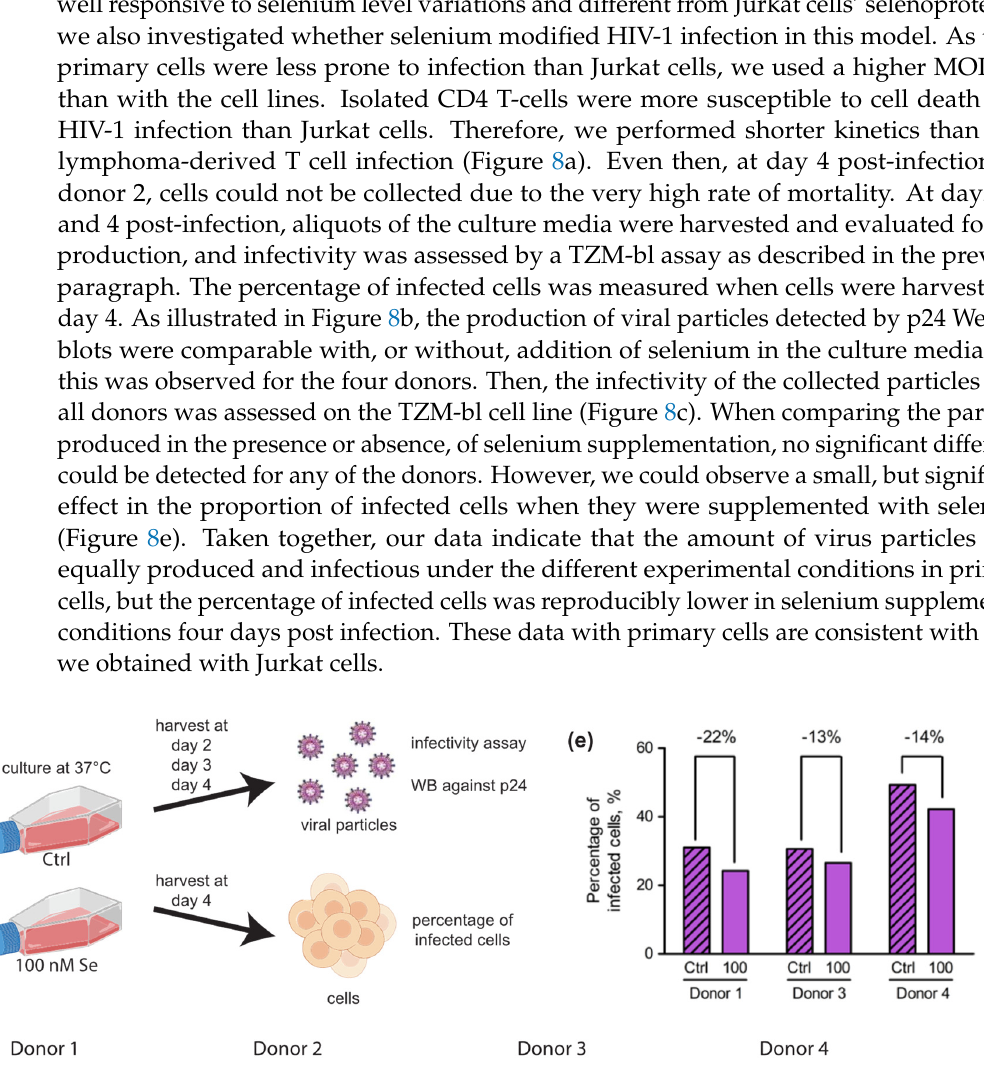
Figure 8. Kinetics of HIV-1 infection of T-cells isolated from donors in Ctrl or 100 nM supplemented conditions ( a – e ). ( a ) Schematic of the experimental procedure used to follow the different parame- ters of viral production and cell infection over four days. Similar to what was done with Jurkat in Figure 7, the media were collected at different time points and evaluated for the levels of p24 ( b ),